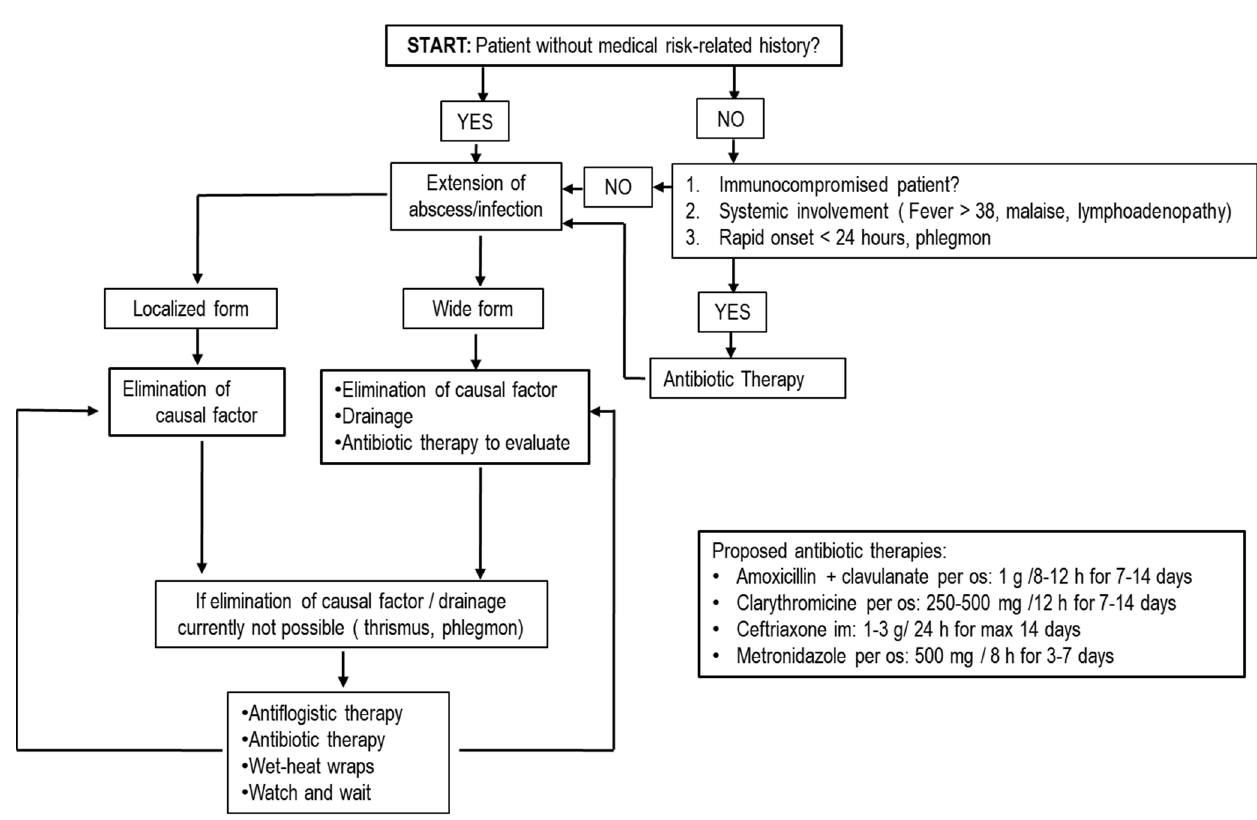
Figure 3. Flowchart for abscesses/suppurative infections in adult patients. In children, posology adjustments must be used as described in Tables 1 and 2. Abbreviations: g = grams; h = hours; per os = oral administration; im = intramuscularly.